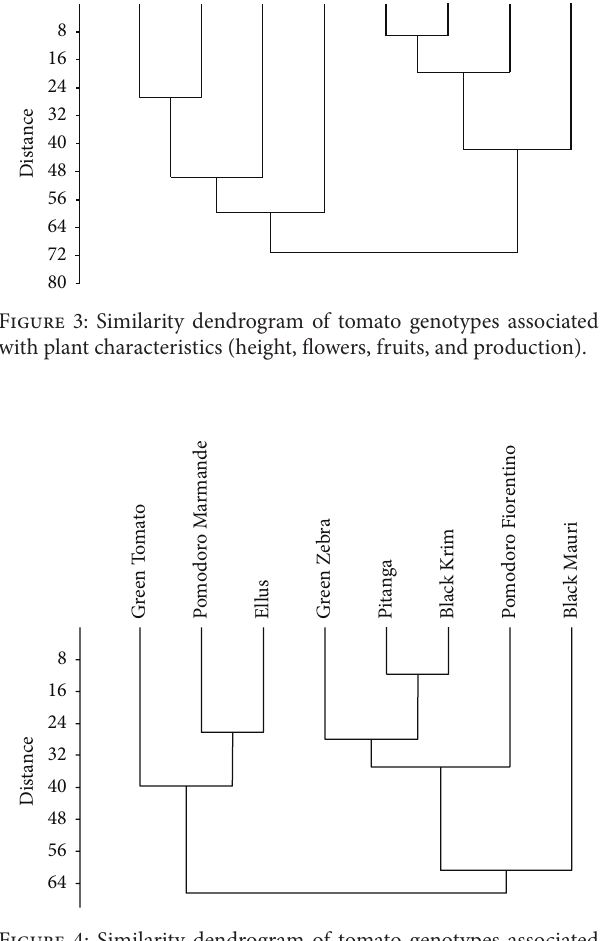
Figure 4: Similarity dendrogram of tomato genotypes associated with fruit characteristics (fresh mass weight, longitudinal and trans- verse diameter, relationship between longitudinal and transverse diameter, epicarp firmness, loci, and number of